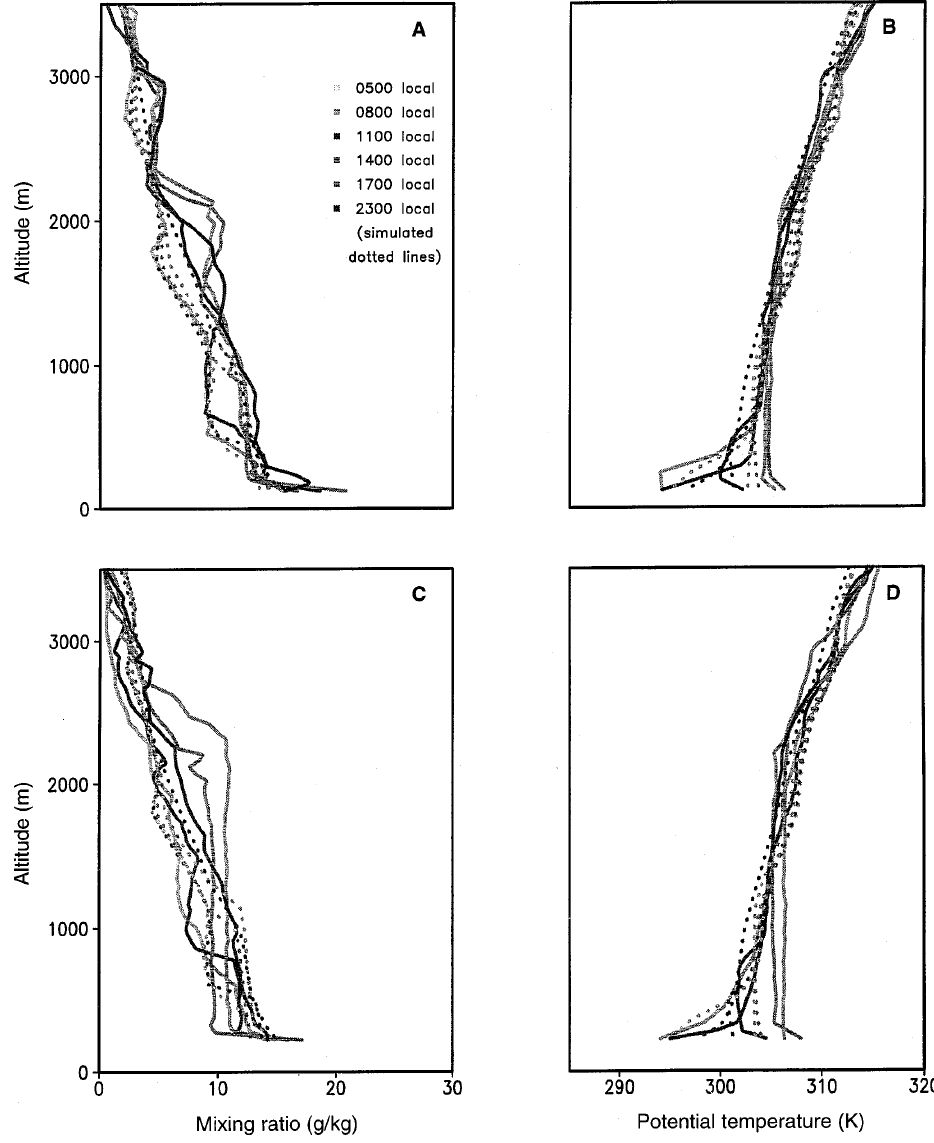
Fig. 9A–D. Simulated ( dotted lines ) and observed ( solid lines ) mixing ratio and potential tem- perature profiles for 18 August for A, B RJF and C, D NSP with the